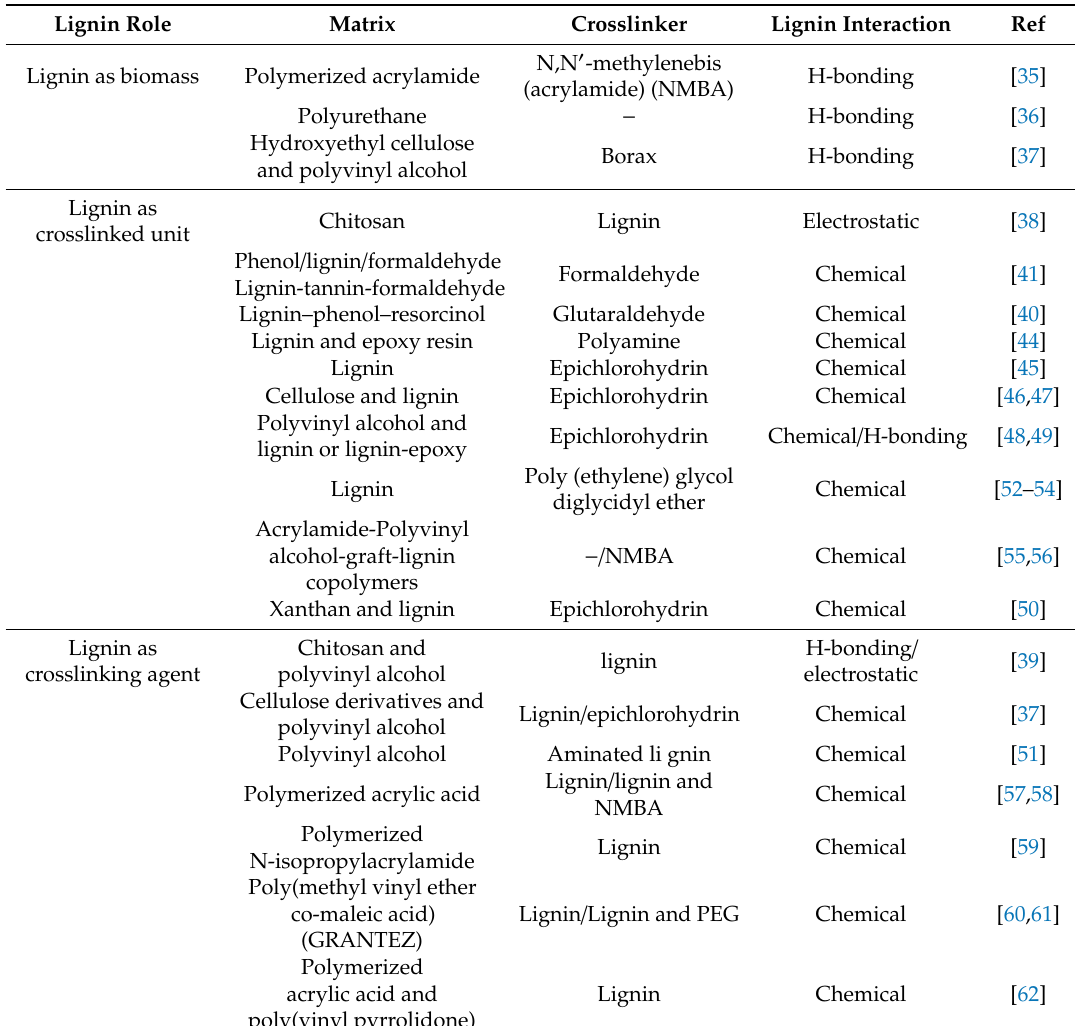
Table 1. Main synthetic strategies described in the bibliography for the development of lignin based